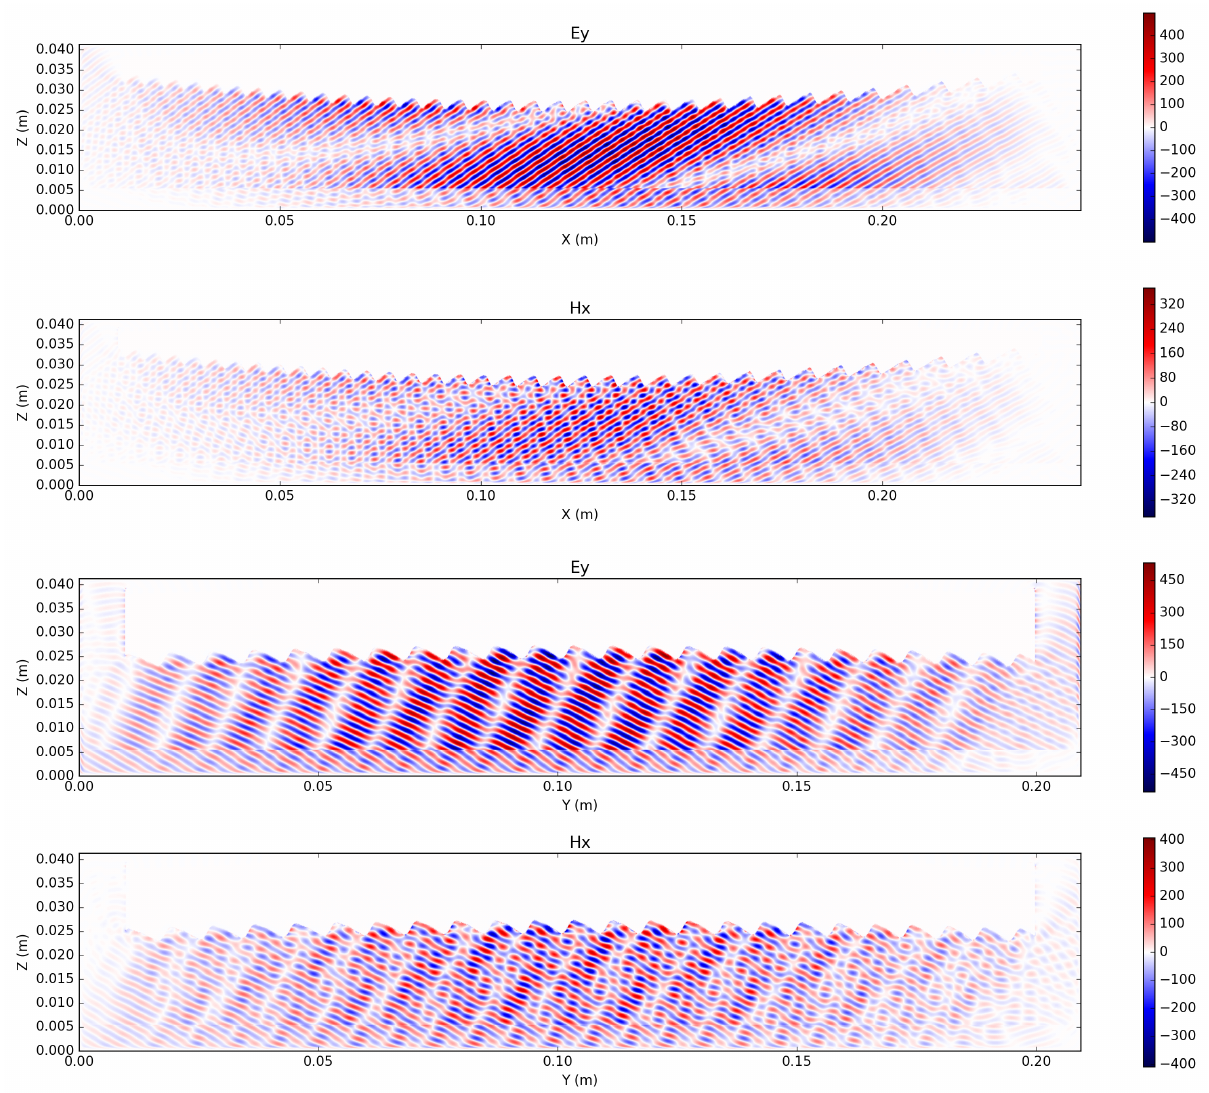
Figure 7. Wave E y and H x fields in the x - z (the two top plots) and y - z (two bottom plots) planes. The grating itself is the white shadow at the top of the plots. The incident wave is injected unidirectionally at z =